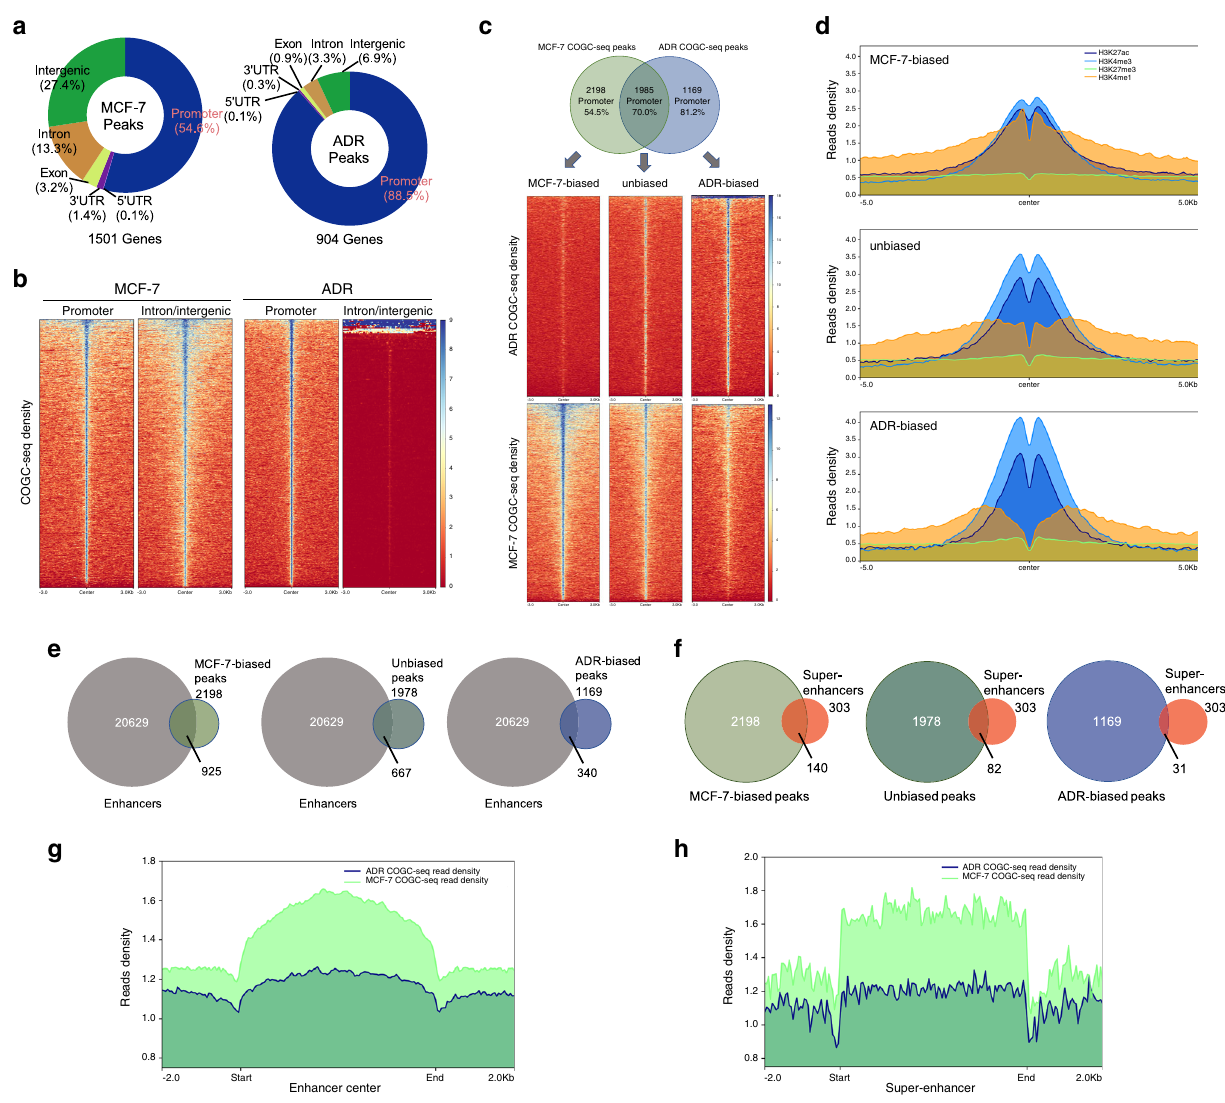
Fig. 3 OCTFs reveal an enhancer-promoter binding switch during exposure to genotoxic stimuli. a MCF-7 and ADR COGC-seq peak annotation relative to known genomic elements. b Heat map representation of the COGC-seq signal at the promoter and intron/intergenic regions bound by OCPs in MCF-7 and ADR cells. Enrichment levels (red, low; blue, high) were pro fi led ±3 kb from the peak center. c COGC-seq occupancy signal in MCF-7-biased, ADR- biased and unbiased peaks identi fi ed by MAnorm (fold change ≥ 2 and P value ≤ 10 − 5 ). Upper panel: Venn diagram showing the overlap of COGC-seq peaks in MCF-7 and ADR cells. The percentage of peaks annotated to promoter regions is indicated. Lower panel: Heat map representation of COGC-seq signal enrichment (red, low; blue, high) at differential quantitative peaks. The enrichment levels were pro fi led ±3 kb from the peak center. d Average enrichment pro fi les of published H3K27ac, H3K4me3 (GSE97481), H3K27me3 (GSE96363) and H3K4me1 (GSE86714) ChIP-seq reads at differential quantitative COGC-seq peaks. e , f Overlap of differential quantitative COGC-seq peaks with MCF-7 enhancer and super-enhancer regions reported previously. g , h Average enrichment pro fi les of COGC-seq reads at MCF-7 enhancer and super-enhancer